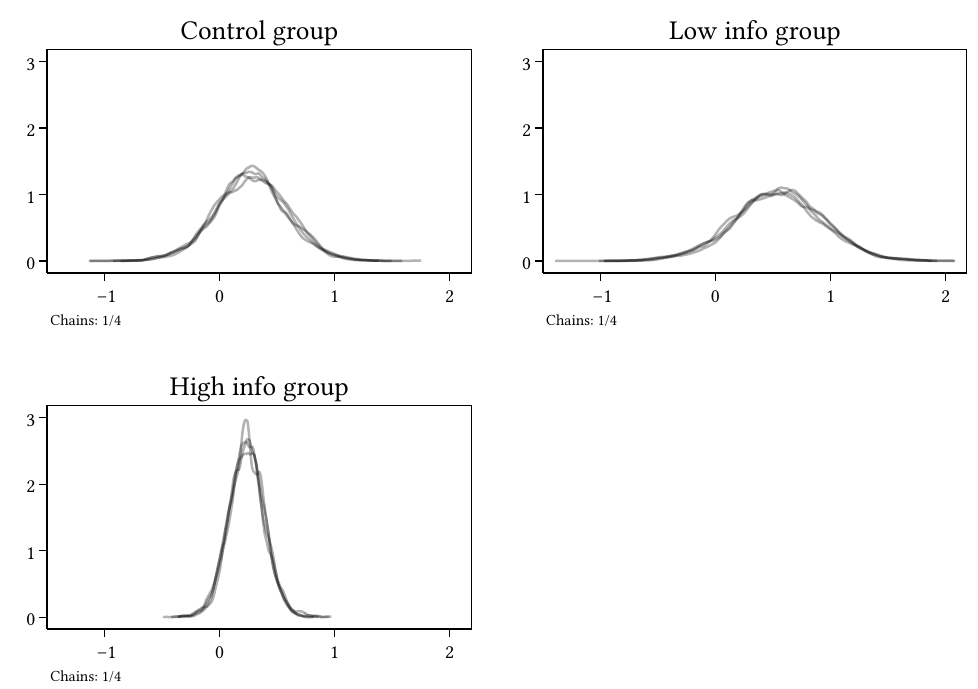
Figure 1. How awareness of the price effect influences response to the median